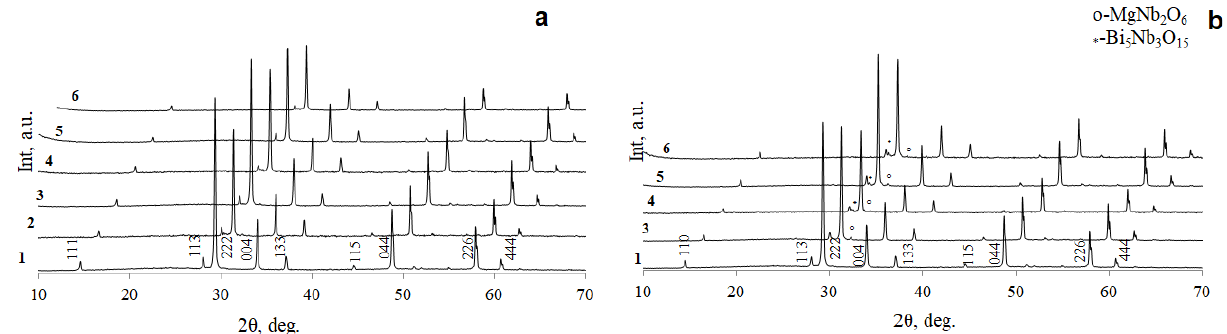
Figure 1: X-ray diffraction patterns of the series of the solid solutions Bi 2 MgNb 2−2 x Fe 2 x O 9− δ (a) and Bi 2 Mg 1− x Fe x Nb 2 O 9+ δ (b) at x=0(1), 0.005(2), 0.01(3), 0.03(4), 0.04(5), 0.06(6)